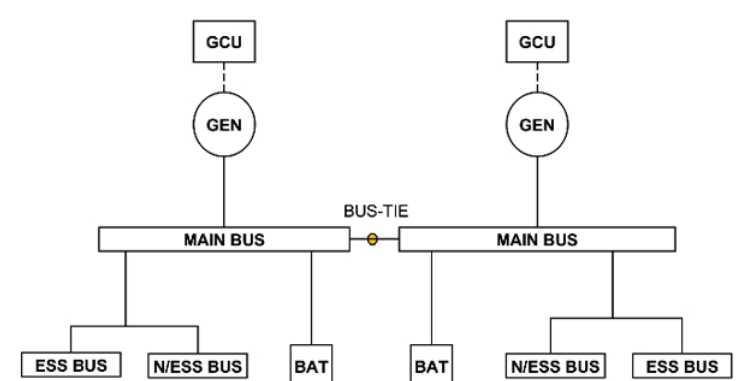
Fig. 2. General aviation generic